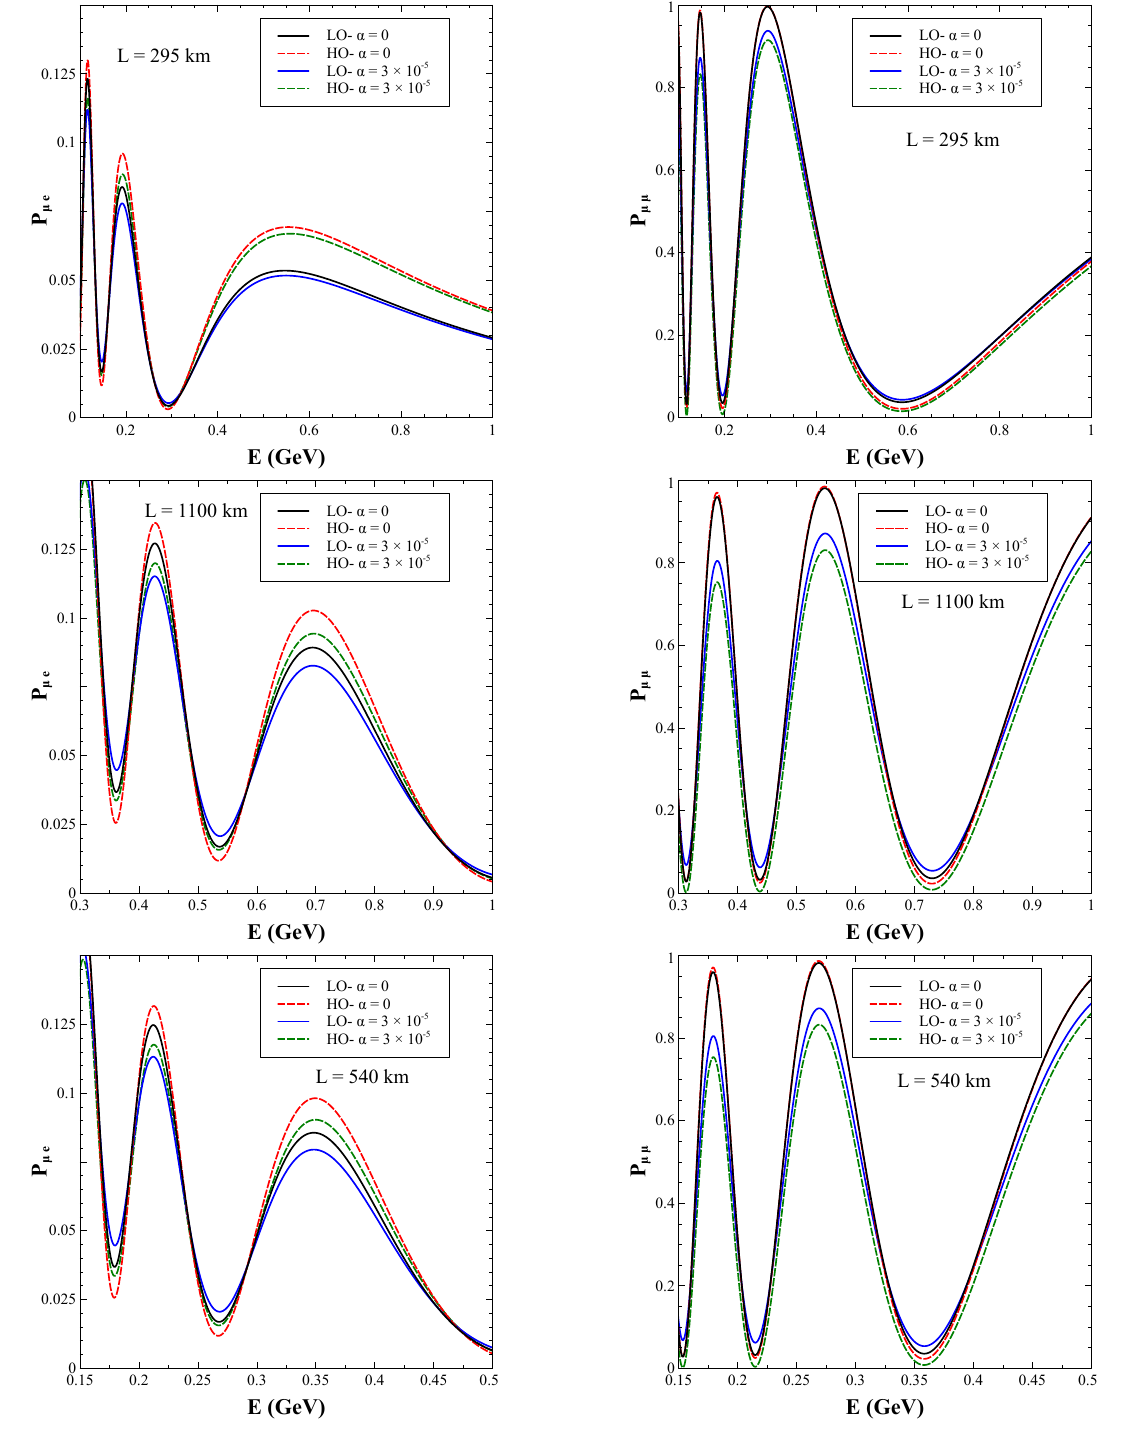
Figure 1 . The probabilities as a function of energy at L = 295 km, 1100 km and 540 km from top to bottom. The left (right) panel shows ν µ → ν e ( ν µ → ν µ ) probabilities. The black (red dashed) curves are for α = 0 and θ 23 in the lower (higher) octant. The blue solid (green dashed) curves are for α = 3 × 10 − 5 eV 2 and θ 23 in the lower (higher) octant. Where, θ 23 = 40 ◦ for LO and θ 23 = 51 ◦ for